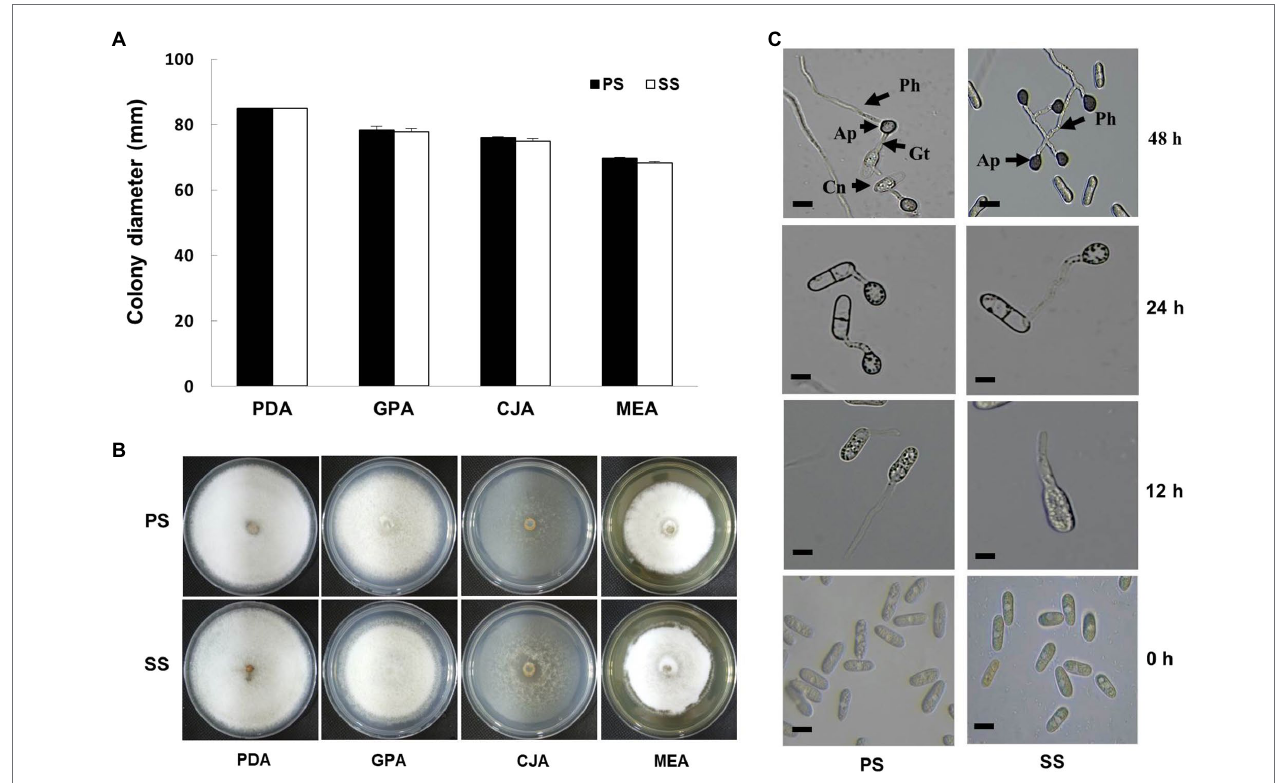
FIGURE 3 | Effect of different media on mycelia growth and morphological characteristics of fungal pathogens. (A) Growth of mycelial colony (in diameter) of progressive (PS) and static (SS) fungal pathogens of C. gloeosporioides in different media was observed as similar in both cases. (B) Representative photographs of mycelial growth and characteristics of fungal mycelia of C. gloeosporioides as progressive and static on different media. Images were photographed 10 days after incubation at 25 ° C. (C) Microscopic observation of appressoria formation and primary hyphae in water-treated conidia suspensions of PS and SS of C. gloeosporioides at different durations (0, 12, 24, and 48 h). Bar = 10 μ m. Ap, Appressorium; Cn, Conidium; Gt, Germ tube; Ph, primary